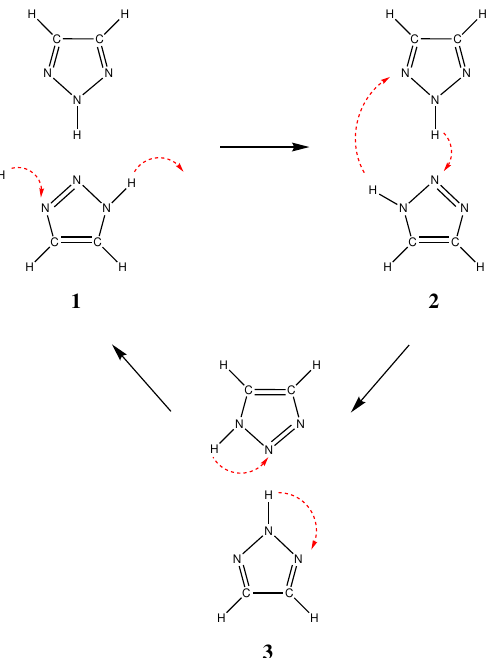
Figure 5. Suggested mechanism for the reorientation as a mandatory step within the Grotthuss mechanism. The first step shows the proton conduction mechanism along the built-in wire structure of the crystalline phases. Step two shows a concerted mechanism which is already discussed in literature [45] and is shown in detail in Figure 6. The third step is tunneling of the protons to their energetically more favorable starting configuration as it is the most stable within the crystal structure.